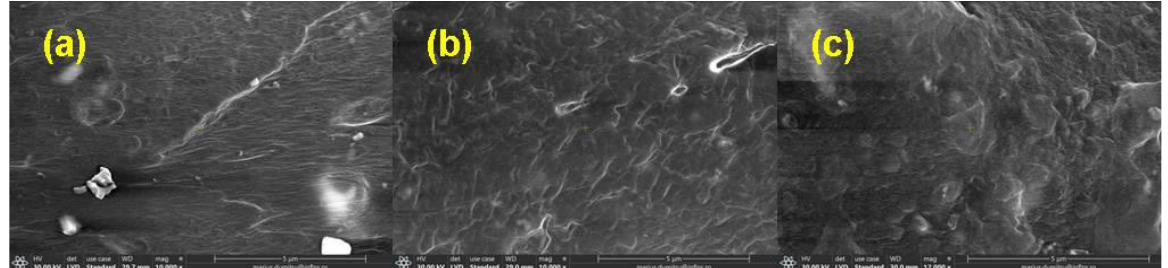
Figure 9. SEM micrographs of mixture D at magnification of 10,000: ( a ) non-irradiated and irradiated at ( b ) 150 kGy and ( c ) 450 kGy.